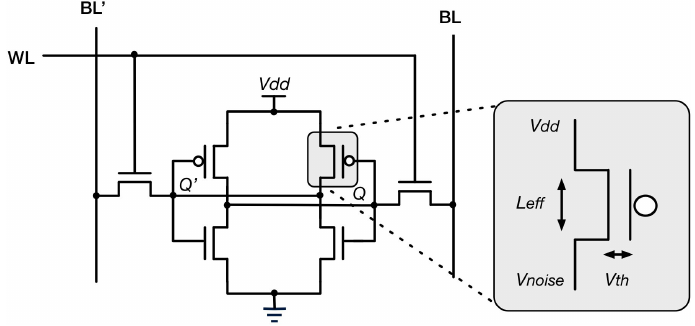
Figure 1. SRAM cell with relevant process variation and noise